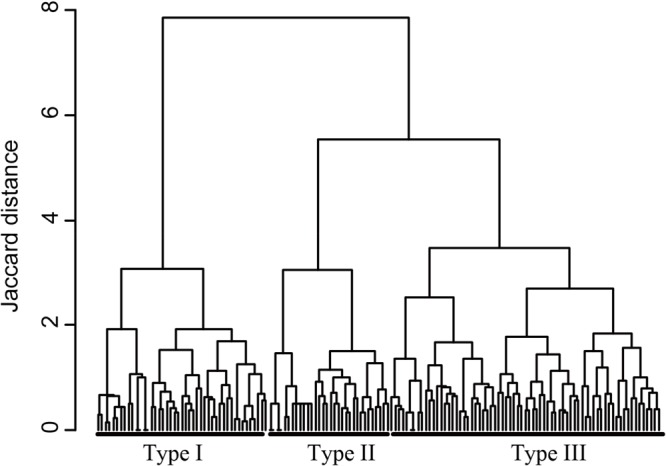
Cluster analysis divided the 148 ponds with at least three macrophyte species into community types based on the presence/absence data. Table 2 provides statistical data for these community types, as well as those for Type IV (one or two macrophyte species) and Type V (no macrophyte species).